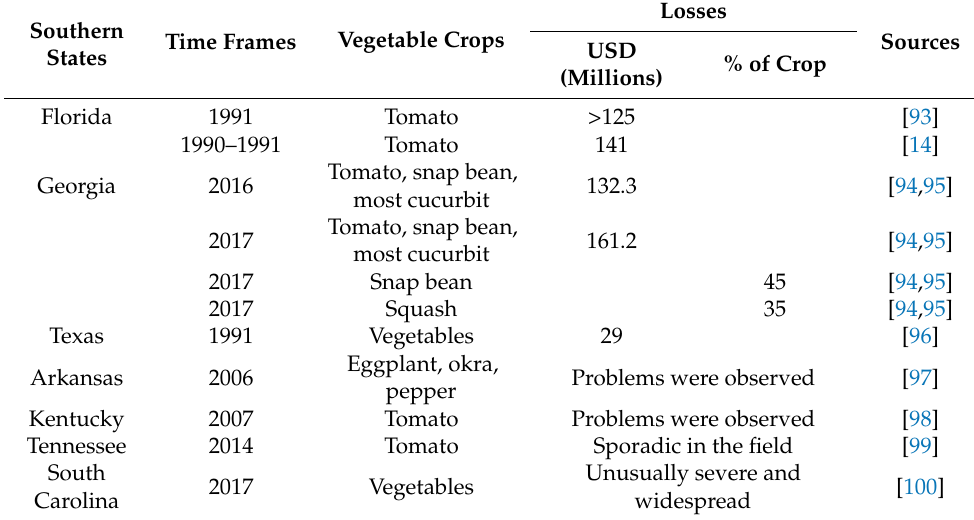
Table 1. Incidence and impact of B. tabaci on vegetable crops in the Southern United